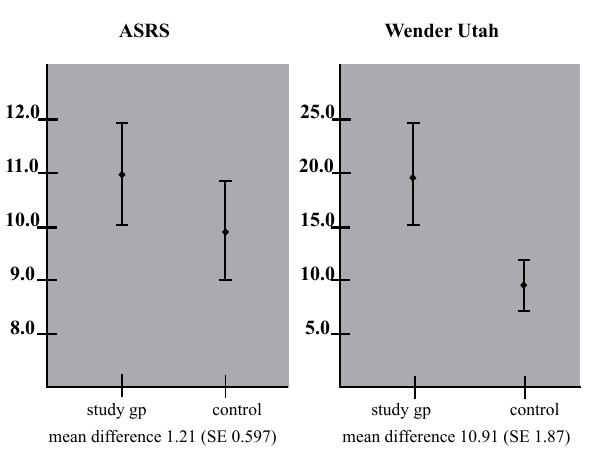
Fig.1 Comparison of means for ASRS and Wender Utah Score between study and control